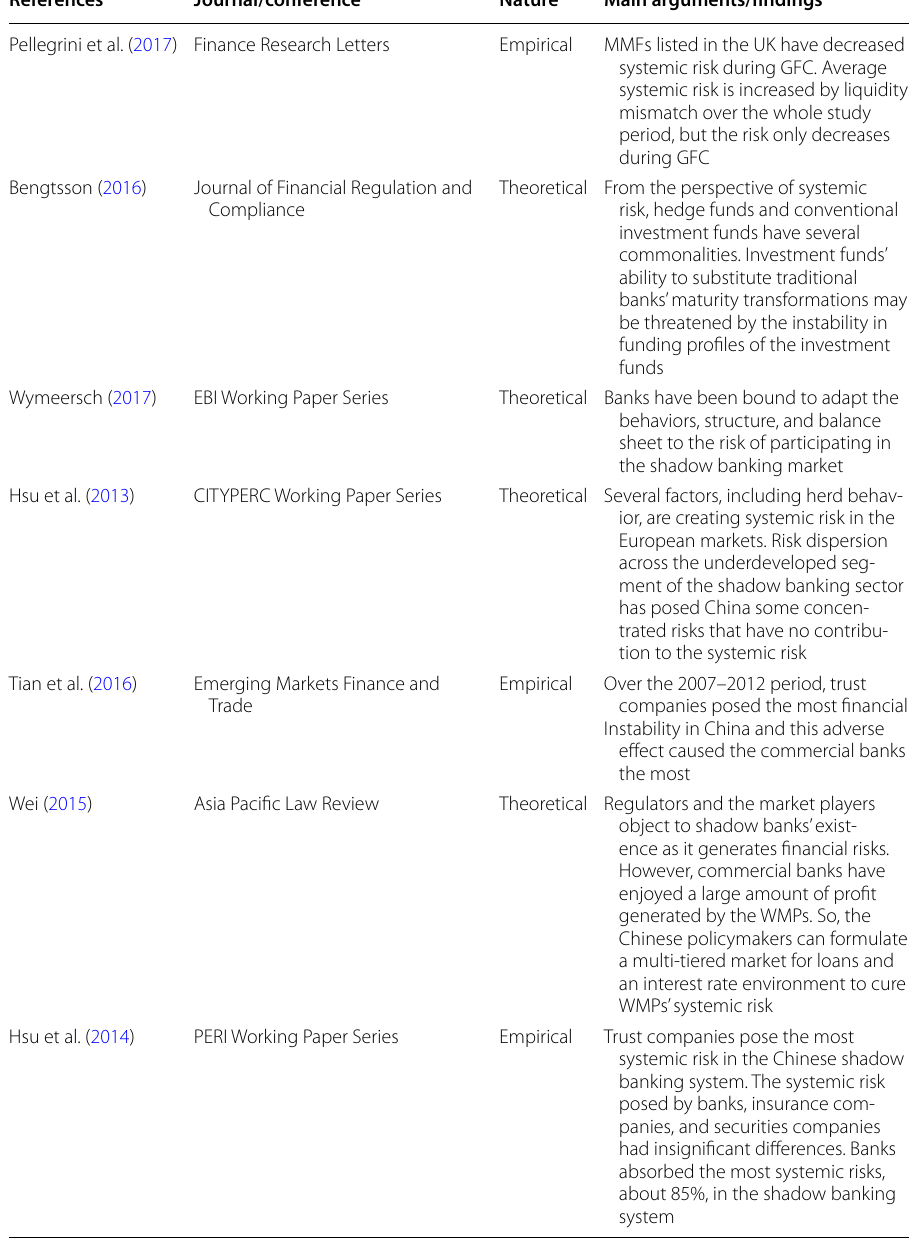
Table 5 Key literature on SB and systemic